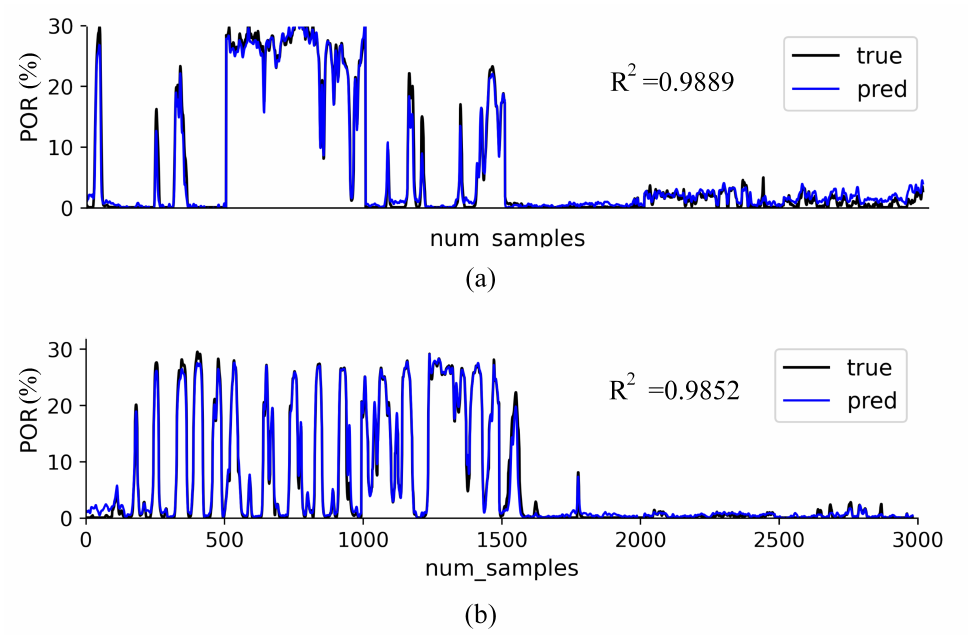
Figure 22. Fitting curve of core porosity and the prediction porosity using TL-Seq2Seq network at test samples. ( a ) Well Luo69, ( b ) Well